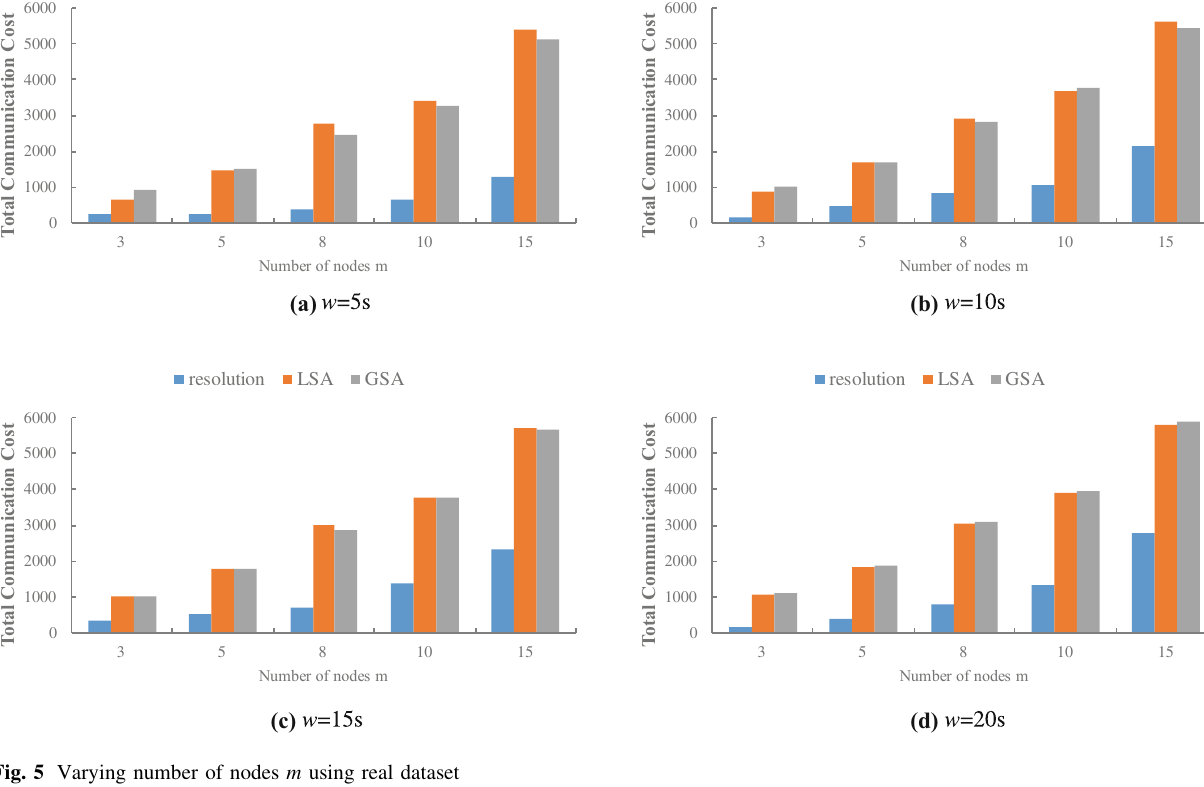
Fig. 5 Varying number of nodes m using real dataset